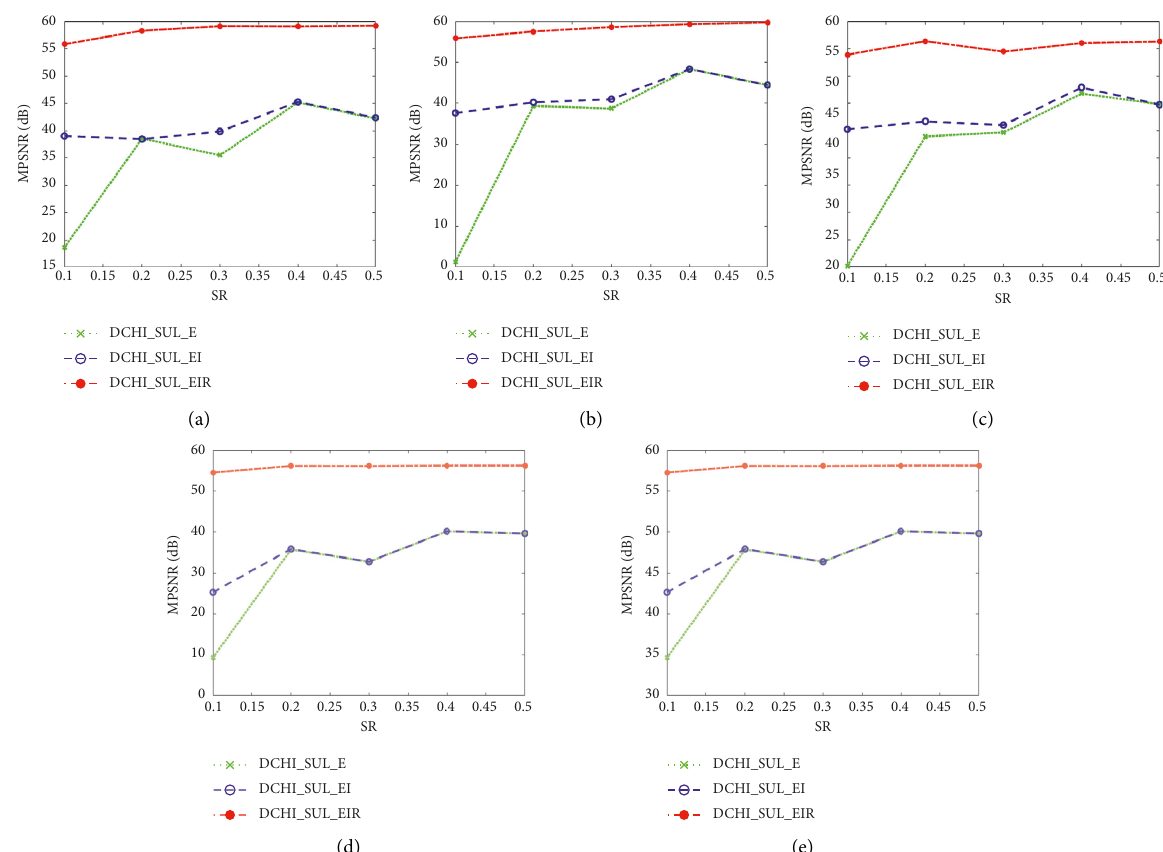
Figure 7: The contribution of the different modules in the proposed DCHI_SUL reconstruction